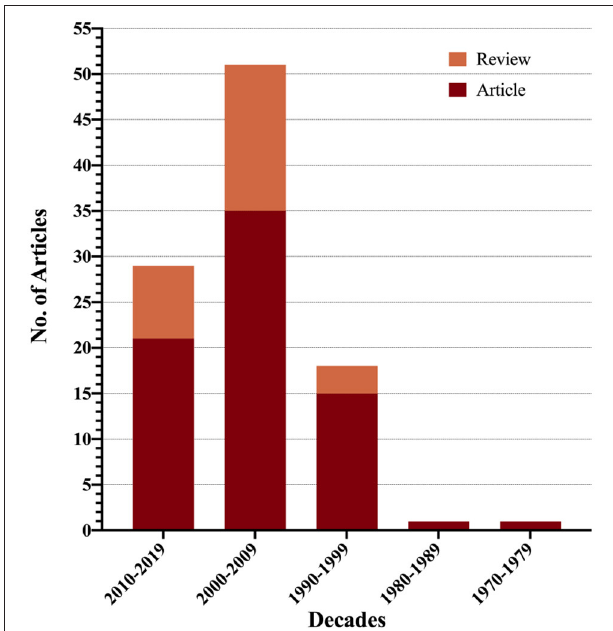
FIGURE 5 | Article types vs. decades.